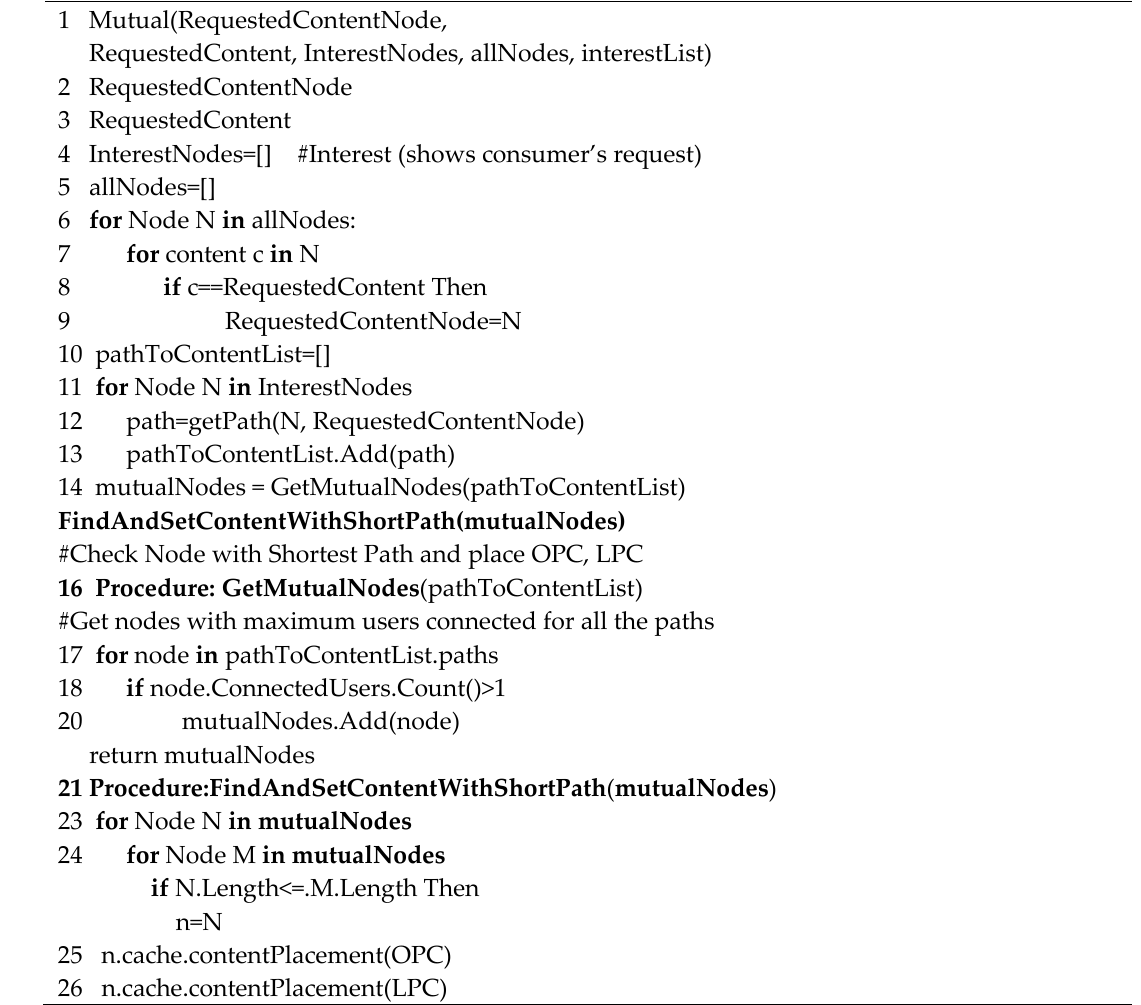
Algorithm 2 Caching of OPC and LPC